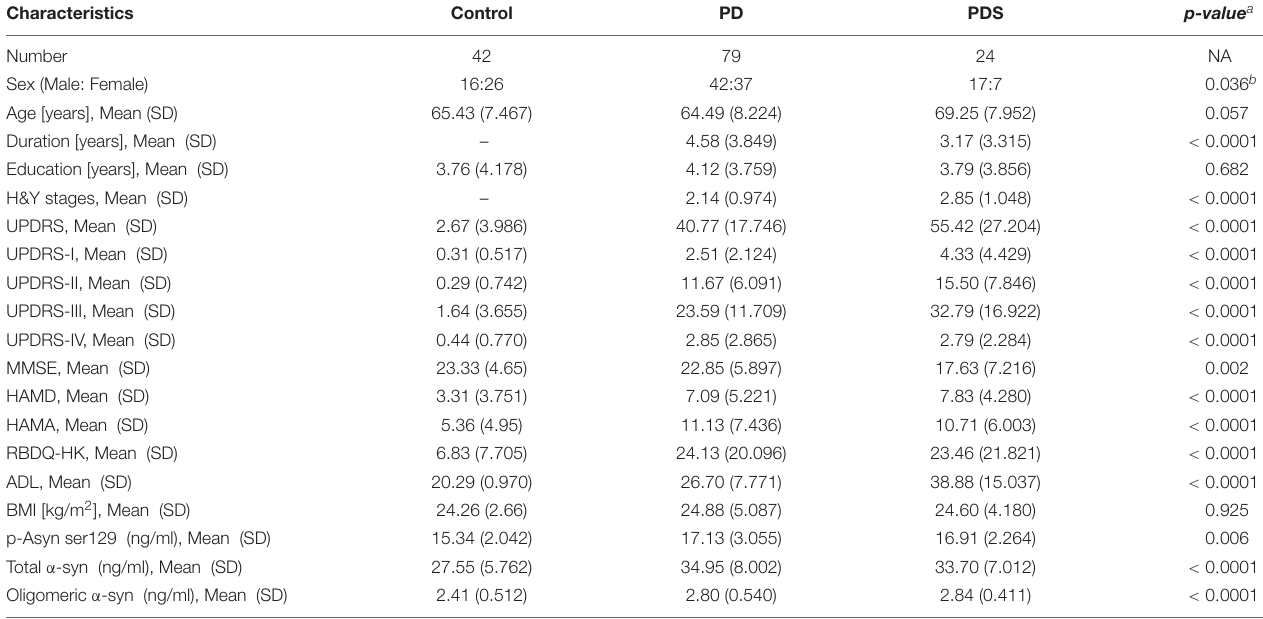
TABLE 1 | Basic demographics and clinical characteristics of the cohort participants. Characteristics Control PD